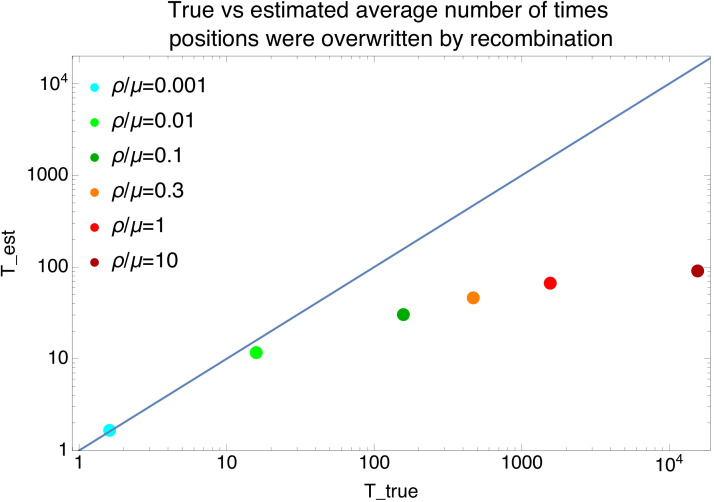
Comparison of the estimated and true average number of times each position in the alignment has been overwritten by recombination for the data of the simulations.Comparison of the true average number of times Ttrue that positions were overwritten by recombination along the branches of the clonal phylogeny (horizontal axis) versus the estimated number of times Test=Lr⁢C/(2⁢L), as estimated from the lower bound on the number of phylogeny changes (with L the length of the alignment and Lr the average length of the recombination segments), for the simulation data. Each dot corresponds to a simulation dataset with a different recombination to mutation rate ρ/μ (see legend). The diagonal line shows the line Te⁢s⁢t=Tt⁢r⁢u⁢e.